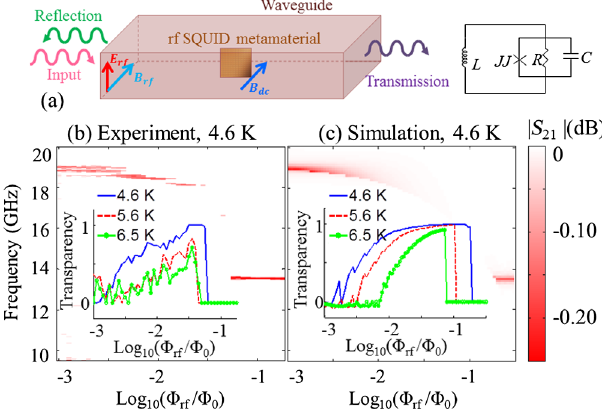
FIG. 1. (a) Schematic of the experimental setup for measuring the transmission of rf SQUID metamaterial oriented perpendicular to the rf magnetic field inside a rectangular wave- guide. The dc magnetic field is applied by sending current into a superconducting coil outside the waveguide. The inset of (a) is the resistively and capacitively shunted junction model of an rf SQUID. Transmission of a single meta-atom at 4.6 K depending on frequency and rf flux is shown in (b) experiment and (c) simulation. The red (dark) feature denotes the resonance dip. Insets plot the transparency as a function of input power under 4.6 K (solid blue lines), 5.6 K (dashed red lines), and 6.5 K (dotted green lines) both for (b) experiment and (c)